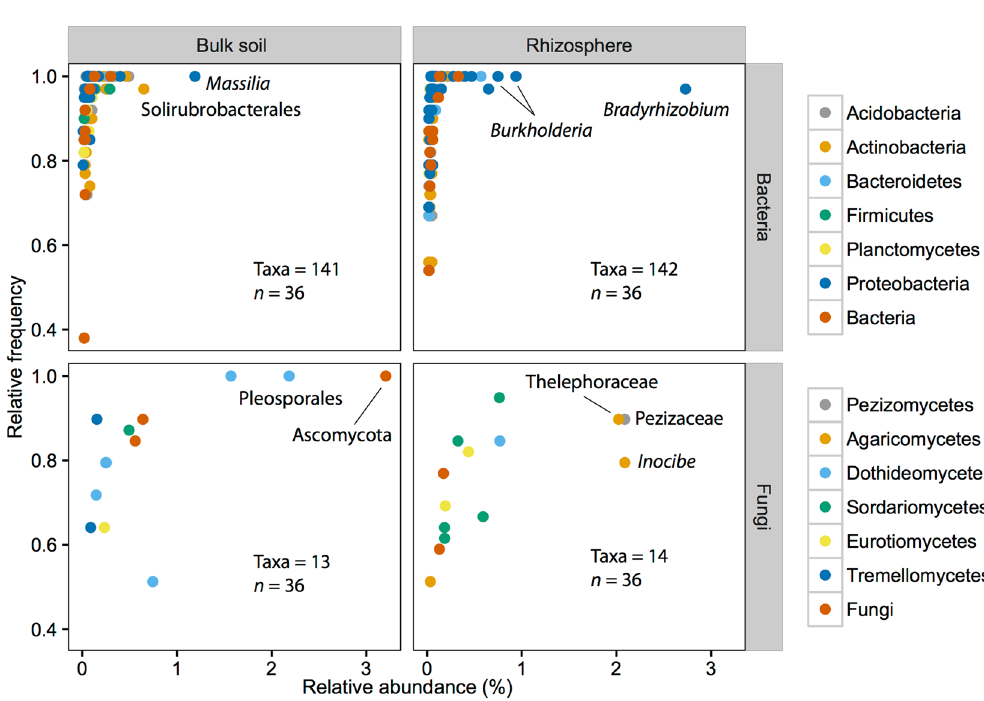
Figure 5. Relative frequency versus relative abundance of biomarker taxa, coloured according to phylum, for bulk and rhizosphere soils (logarithmic LDA score ≥ 2, P < 0.05). The number of biomarker taxa (OTUs) and the number of samples ( n ) are indicated in each